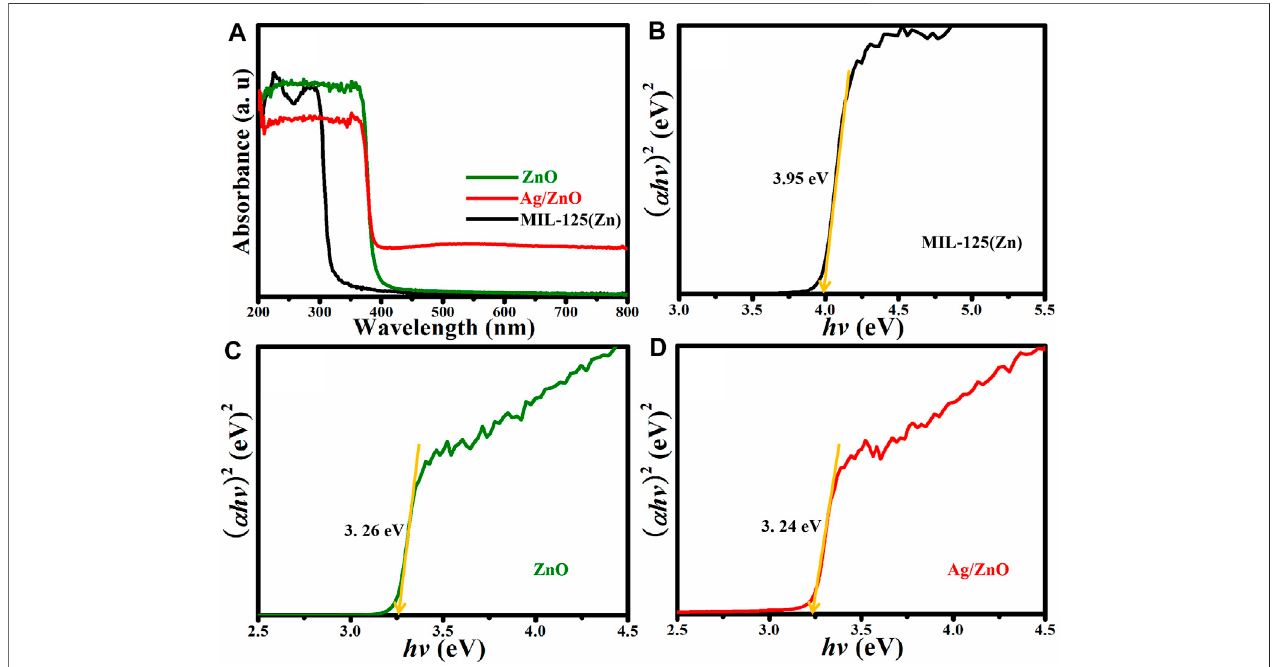
FIGURE 5 | (A) UV-vis diffuse re fl ectance spectra and (B – D) Kubelka – Munk plots of MIL-125(Zn), ZnO, and